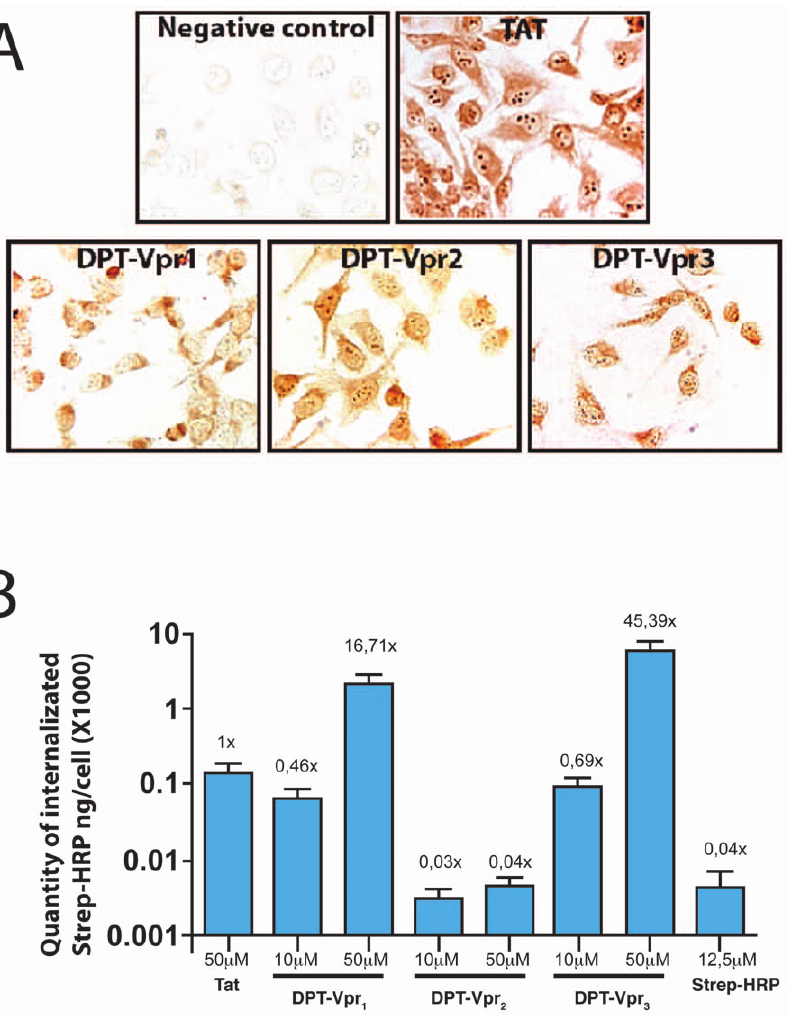
Figure 2. Effect of DPT-Vpr peptides on cell penetration and intracellular delivery of streptavidin-peroxydase. (A) For penetration and localization analysis, cells were incubated with 150 m M of peptides for 2 h at 37 u C. After fixation, the presence of biotinynlated peptides is revealed by incubation of permeabilized cells with streptavidin-peroxydase. The sequence of non penetrating peptide used as negative control is GVIFYLRDK. The sequence of positive Tat control is YGRKKRRQRR. (B) Intracellular delivery of streptavidin-peroxydase by biotinylated-DPT-Vpr and Tat peptides in HeLa cells. Streptavidin-peroxydase coupled with biotinylated peptides were incubated for 6 h at 37 u C and internalized complexes were visualized by a colorimetric test. Statistical analysis was carried out using Anova’s test and significance was assessed at p , 0.0001.